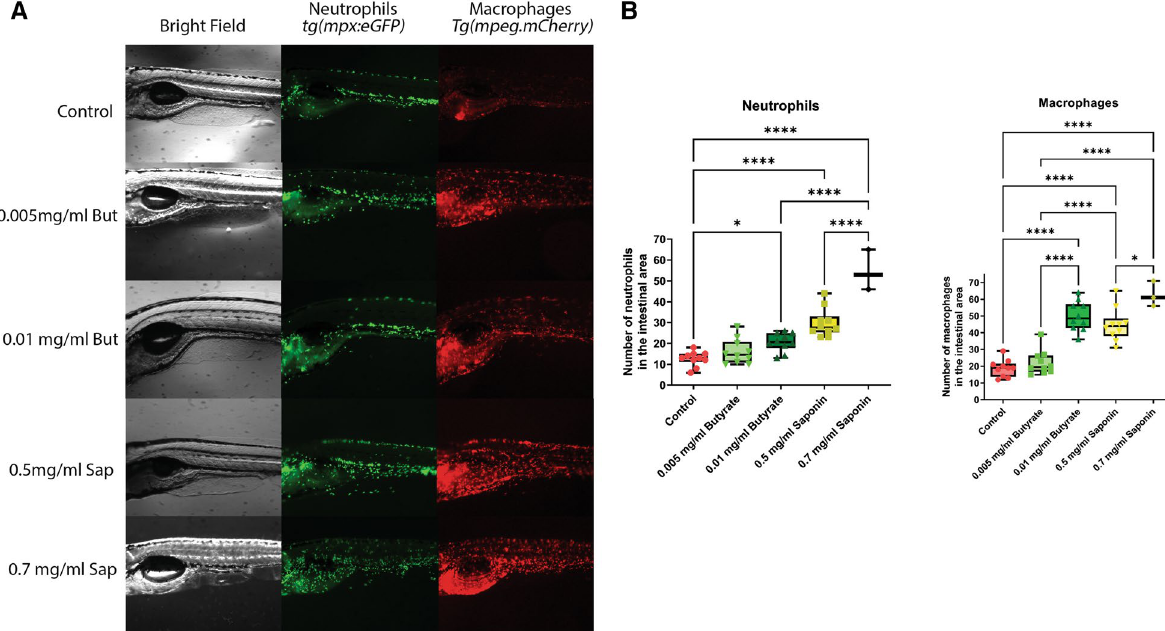
Fig. 9 A Representative pictures of the fluorescent in vivo imaging of the gut area of Tg(mpeg1:mCherry / mpx:eGFPi 114 ) larvae exposed to control media, 0.005 mg/ml and 0.01 mg/ml butyrate and 0.5 mg/ml and 0.7 mg/ml saponin. B Quantification of neutrophils and macrophages in the gut area of the zebrafish larvae (n 10 in all groups except 0.7 mg/ml saponin where n = non-normally distributed data by Shapiro–Wilk test. Whiskers: min. to max. shall all points with